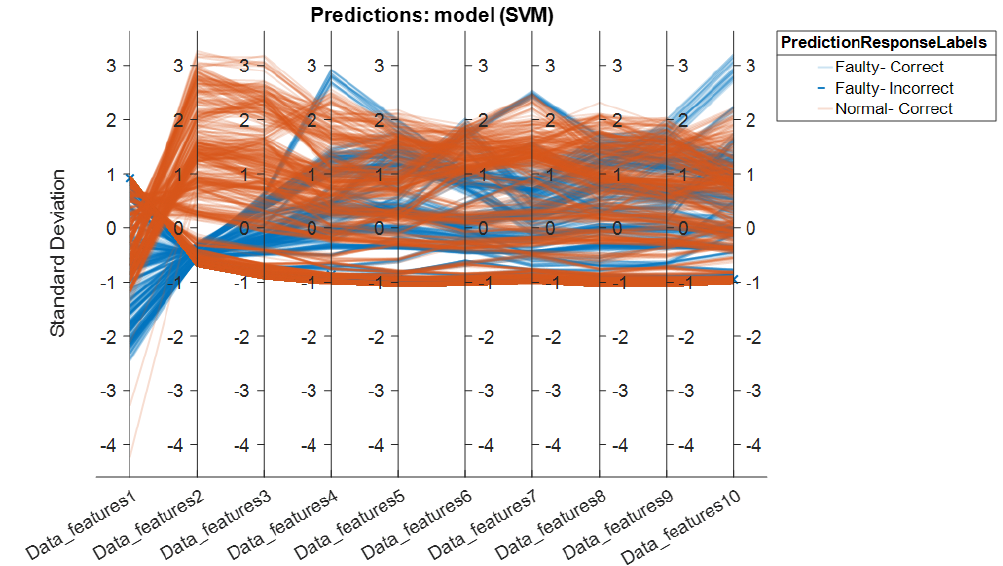
Figure 20. Parallel coordinate plot for the highest-scoring classifier (SVM) for Robostar fault classifications.